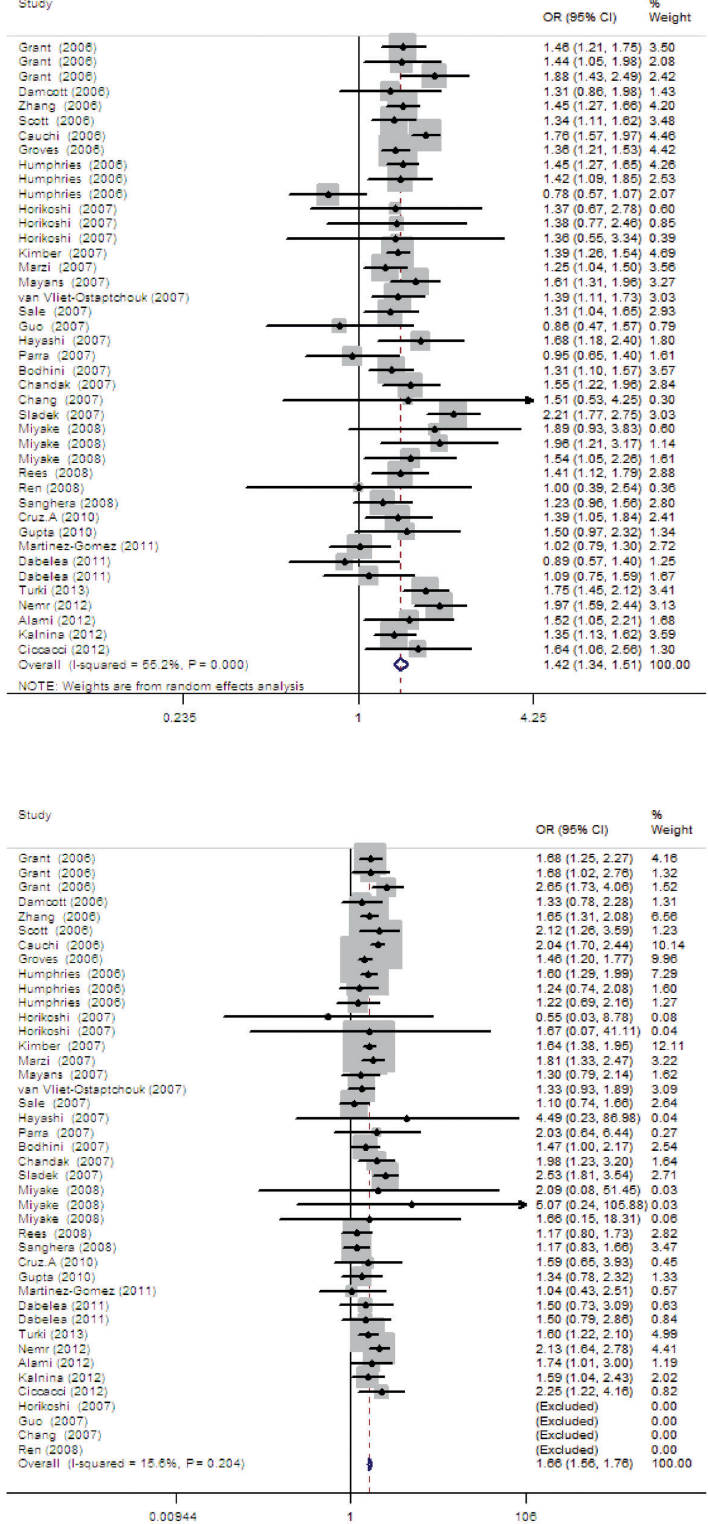
Figure 4. Meta-analysis of the associa- tion between type 2 diabetes and the dominant model of rs12255372.